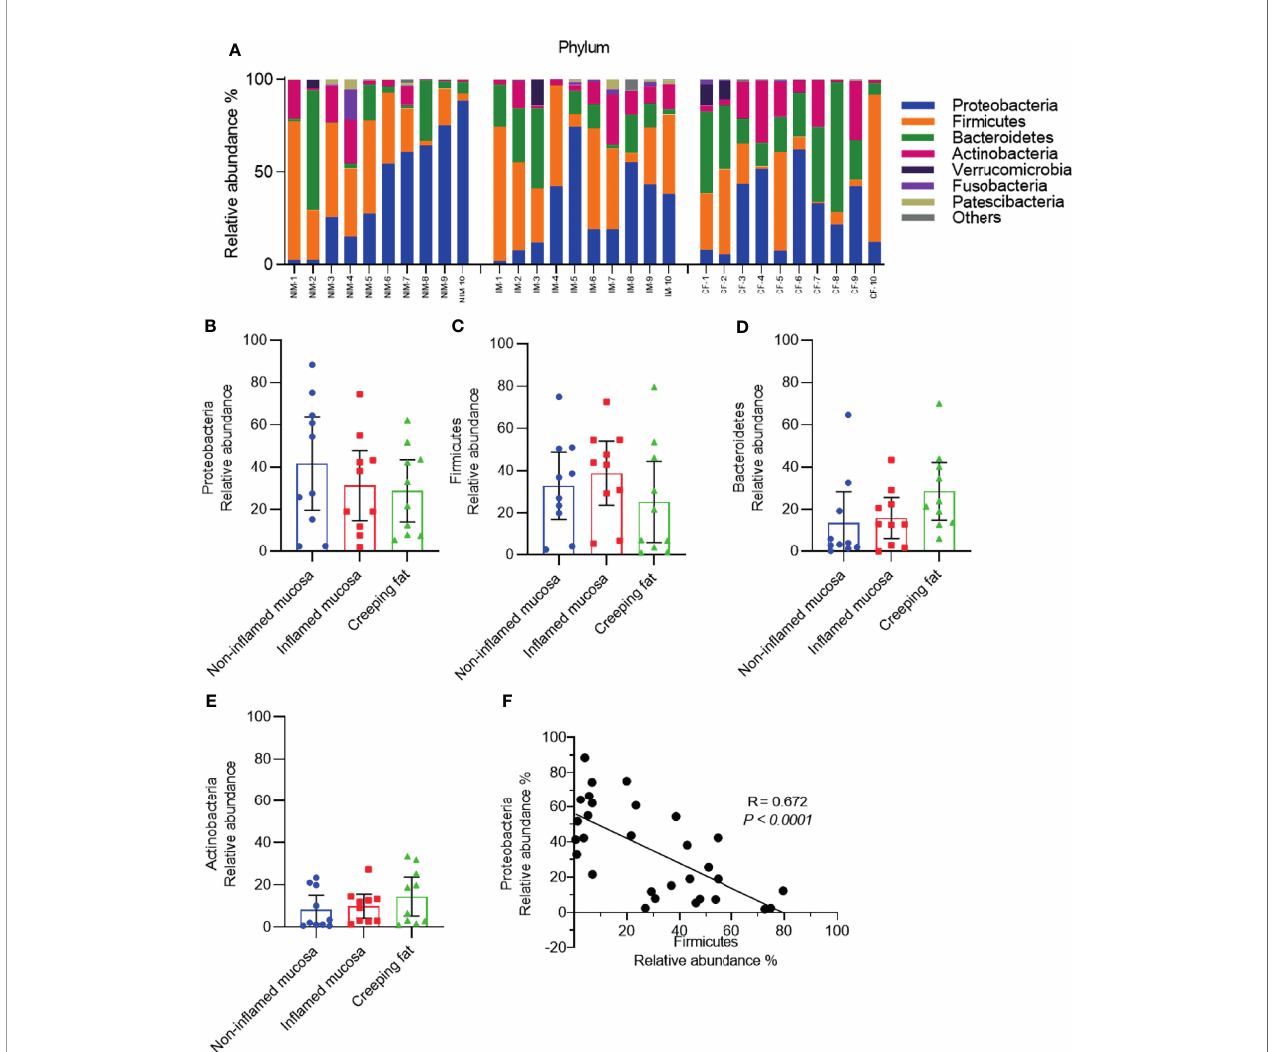
FIGURE 2 | Analysis of the predominant bacterial composition at the phylum level. (A) Histograms of the predominant bacterial phyla in nonin fl amed mucosa (NIM), in fl amed mucosa (IM), and creeping fat (CF) from CD patients. (B – E) Dynamic change in the relative abundances of Proteobacteria (B) , Firmicutes (C) , Bacteroidetes (D) , and Actinobacteria (E) . (F) Correlation analysis between Proteobacteria and Firmicutes. Data are presented as the mean ± 95% CI; p -value calculated by one- way ANOVA with Tukey ’ s multiple comparisons